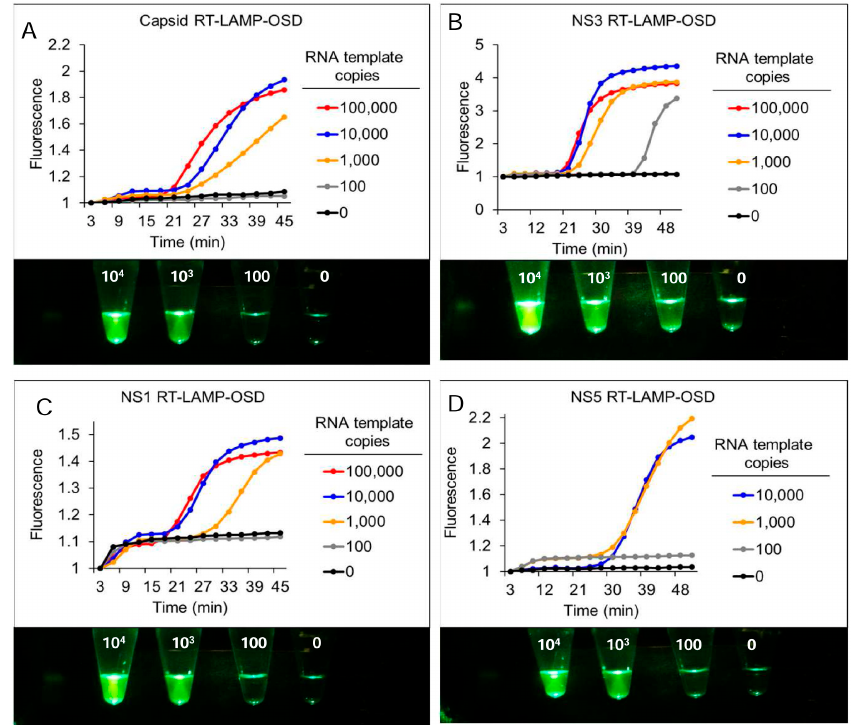
Figure 2. Detection of Zika virus capsid , NS1 , NS3 , and NS5 genes using real-time and visually-read reverse transcription LAMP-OSD assays. Indicated copies of capsid ( A ), NS3 ( B ), NS1 ( C ), and NS5 ( D ) synthetic RNA templates were amplified by degenerate LAMP-OSD assays specific to each template. OSD fluorescence signals measured in real-time during LAMP amplification are depicted as red (10 5 template copies), blue (10 4 template copies), orange (10 3 template copies), gray (100 template copies), and black (0 template copies; 10 6 non-template RNA) traces. The x -axis depicts the duration of LAMP amplification. OSD fluorescence was also imaged at amplification endpoint using a cellphone (images depicted at the bottom of each panel). Numbers on each assay tube in these images indicate the RNA template copies used. Representative results from three replicate experiments are